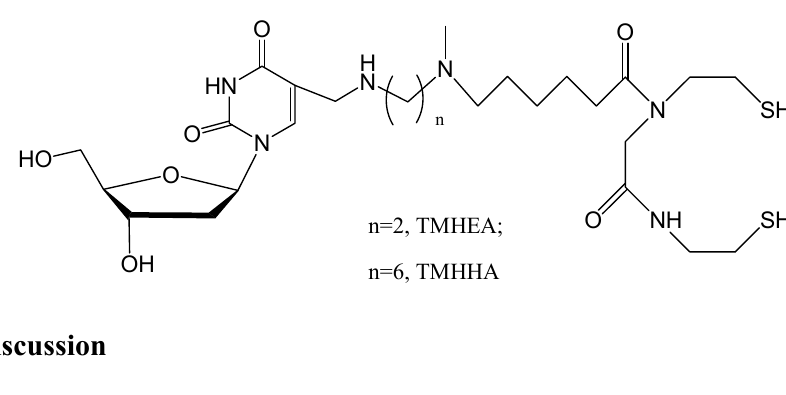
Figure 1. Structures of TMHEA and